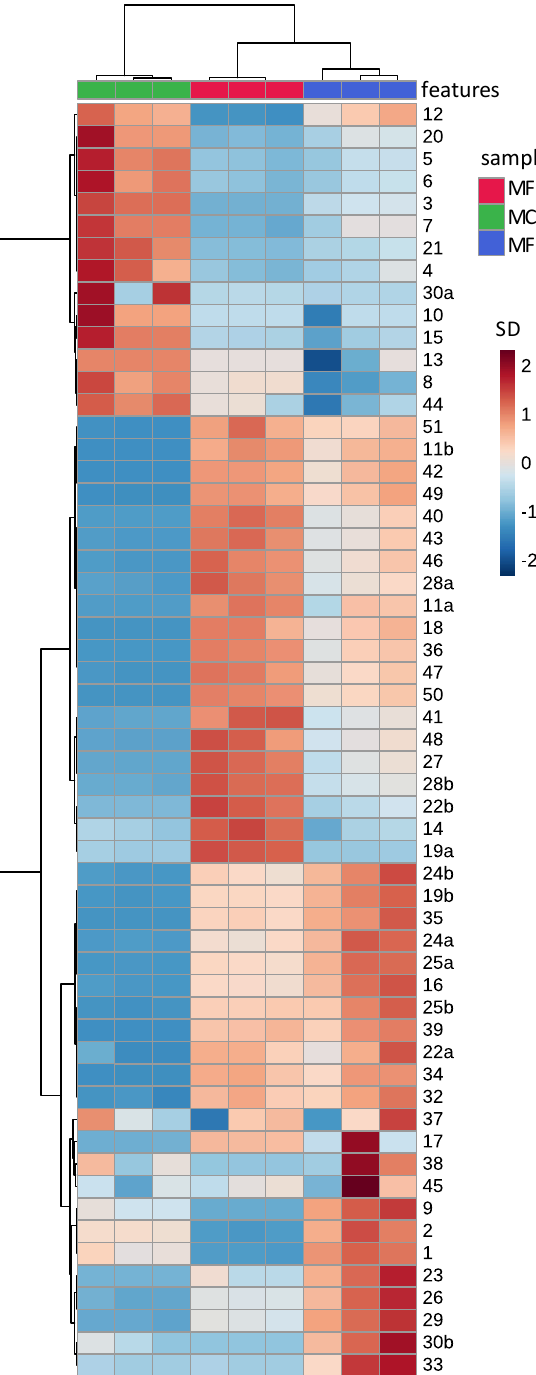
Figure 3. Clustergram derived from the area ratio of the phytochemicals estimated from the LC-MS/MS analysis of triplicate methanolic extracts of three types of kawakawa. Each row represents a resolved feature (Table 2) and each column represents one triplicate analysis from the eight different leaf sources. Heat scale units are standard deviations from the mean of all peaks for that feature. Hierarchical clustering on each axis demonstrates similarity of features ( y axis) and samples ( x axis). The first letter of the sample label indicates methanolic, the second letter commercial dried leaves (C) or fresh leaves (F) and the third the source as listed in Table 1.